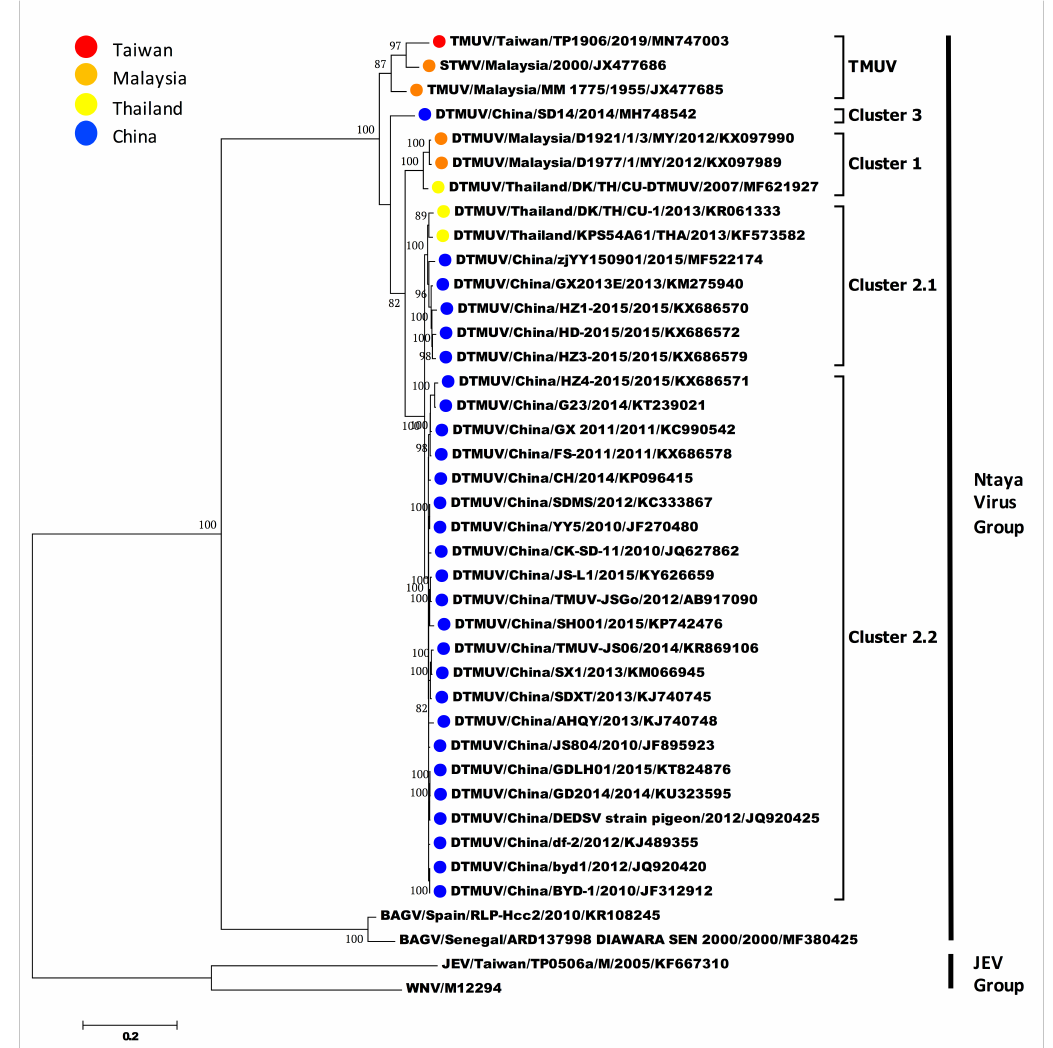
Figure 3. Phylogeny of TMUV-TP1906, Tembusu virus strains (TMUVs) and duck Tembusu virus strains (DTMUVs) based on the ORF (10,278 nt). The evolutionary history was inferred by using the maximum likelihood method based on the Tamura–Nei model [22]. The tree with the highest log likelihood is shown. The percentage of trees in which the associated taxa clustered together is